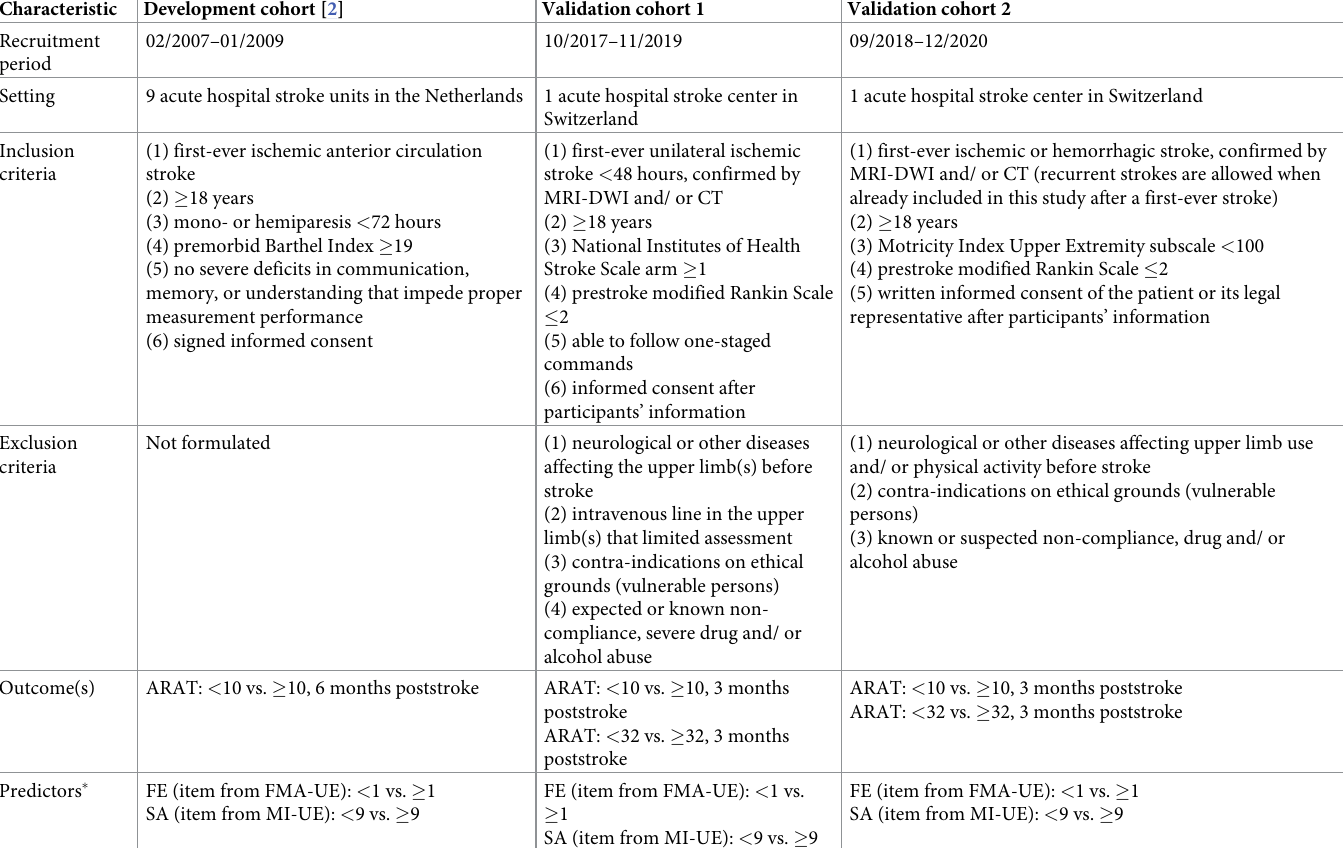
Table 1. Key characteristics of the development and validation